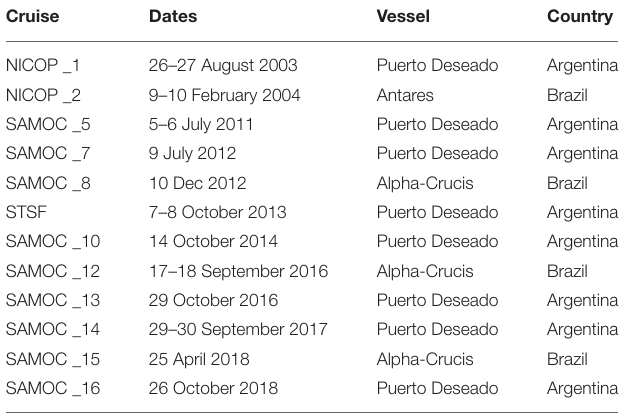
TABLE 1 | Hydrographic surveys along the Albardão transect.